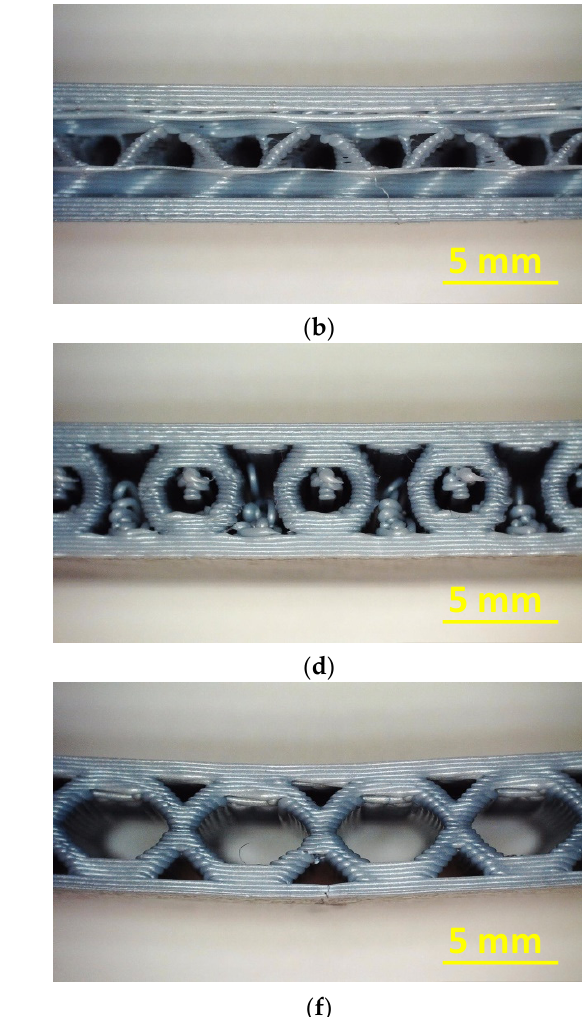
Figure 3. Bending and recovery tests of samples with different infill patterns: ( a ) LN100; ( b ) GY15; ( c ) OC15; ( d ) ZHR100; ( e ) LP100; and ( f ) EW100. Y-axis scales differ. Bending was performed till the deflection at which maximum force occurred, as measured in the previous tests.